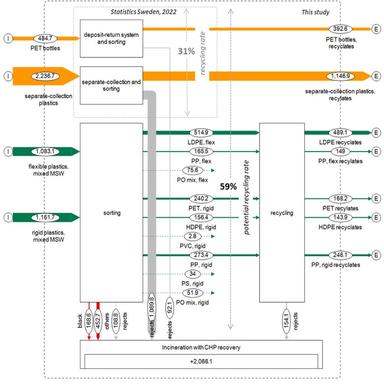
Material flow diagram (in tons, on a dry basis) of the potential recycling of plastic packaging in mixed MSW, shown in relation to the overall plastic packaging waste management system including separate-collection and deposit-return system in the Swedish case city in 2022. Note: orange = calculated from secondary data, green = calculated using primary data, gray = calculated using mass-balance, red = assumed not well-recyclable. (For interpretation of the references to color in this figure legend, the read